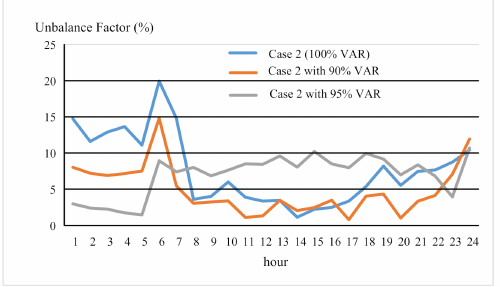
Figure 12. The VAR of daily unbalance factor at the various confidence levels.